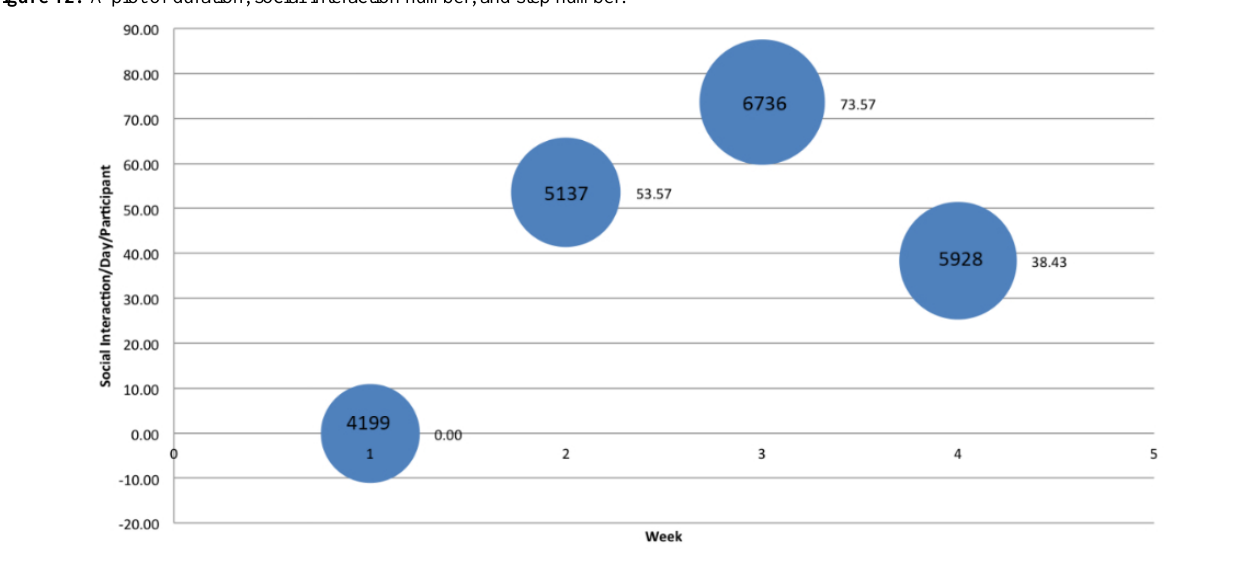
Figure 12. A plot of duration, social interaction number, and step